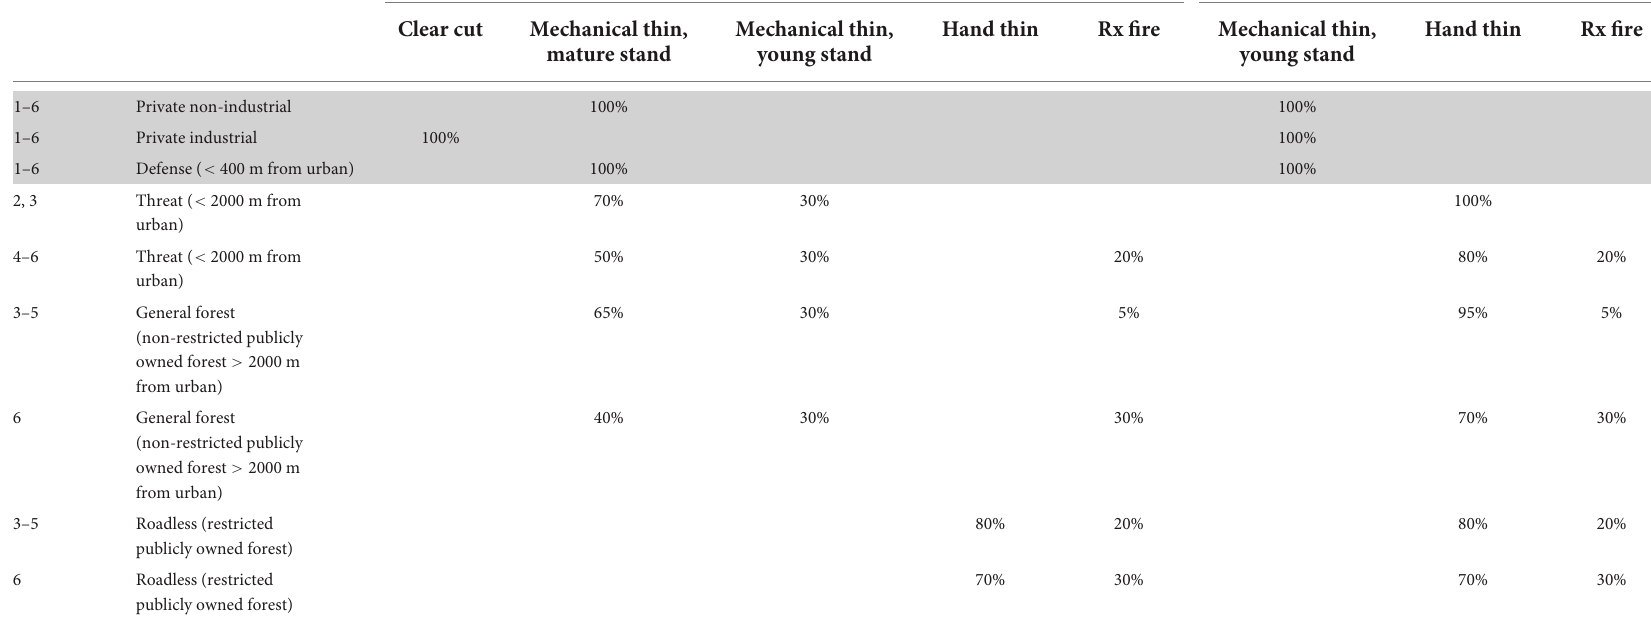
TABLE 3 Percent of different treatment prescriptions by scenario, management zone, and slope.